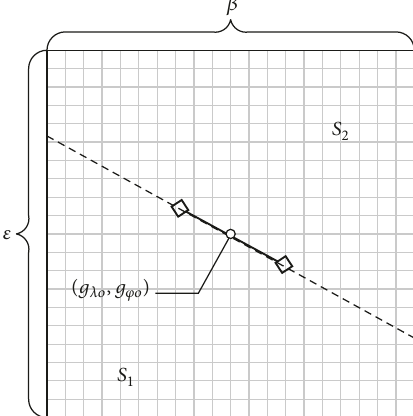
Figure 1: Method of determining the initialization vector.